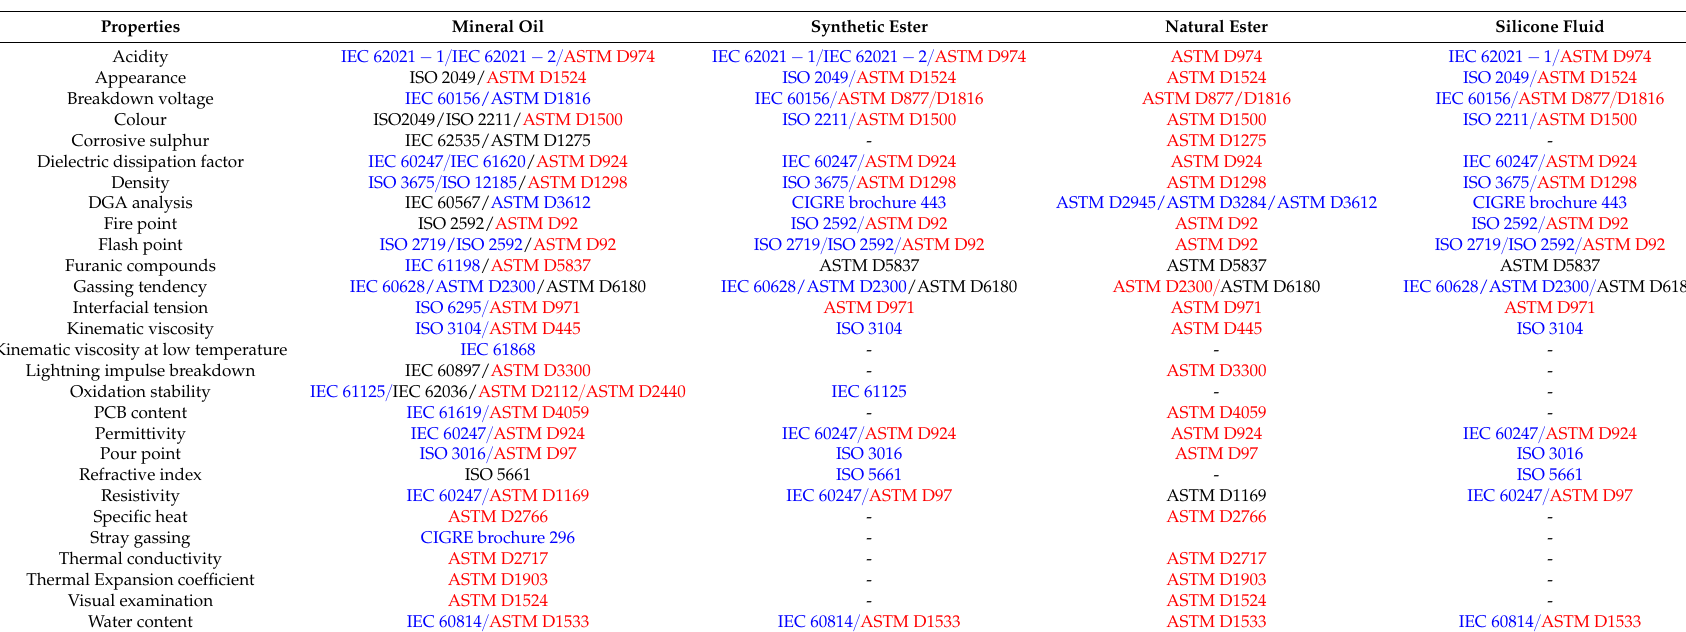
Table 8. Fluid testing methods adapted from [31]. Most commonly used IEC methods are in blue; most commonly used ASTM methods in red while standard not quoted but generally used are in